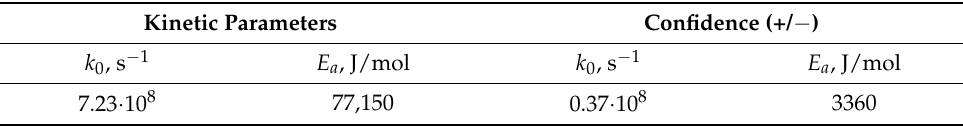
Table 2. Kinetic constants for de-N 2 O